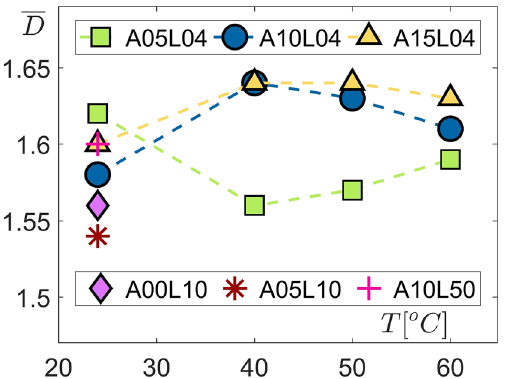
Figure 7. Averaged fractal dimensions D compared for 15 different two-phase flow conditions imposed by varying the liquid flow rates ( L 04, L 10 and L 50 cases), bio-oil preheating temperatures ( T 24, T 40, T 50 and T 60 cases) and air flow rates ( A 05, A 10 and A 15 cases).